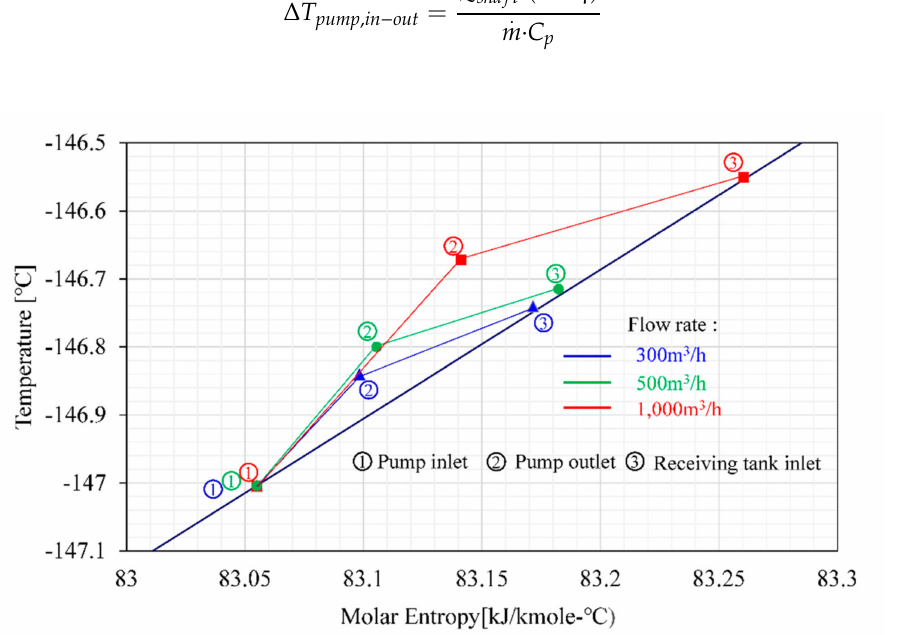
Figure 5. T–s diagram at bunkering flow rates of 300, 500, and 1000 m 3 /